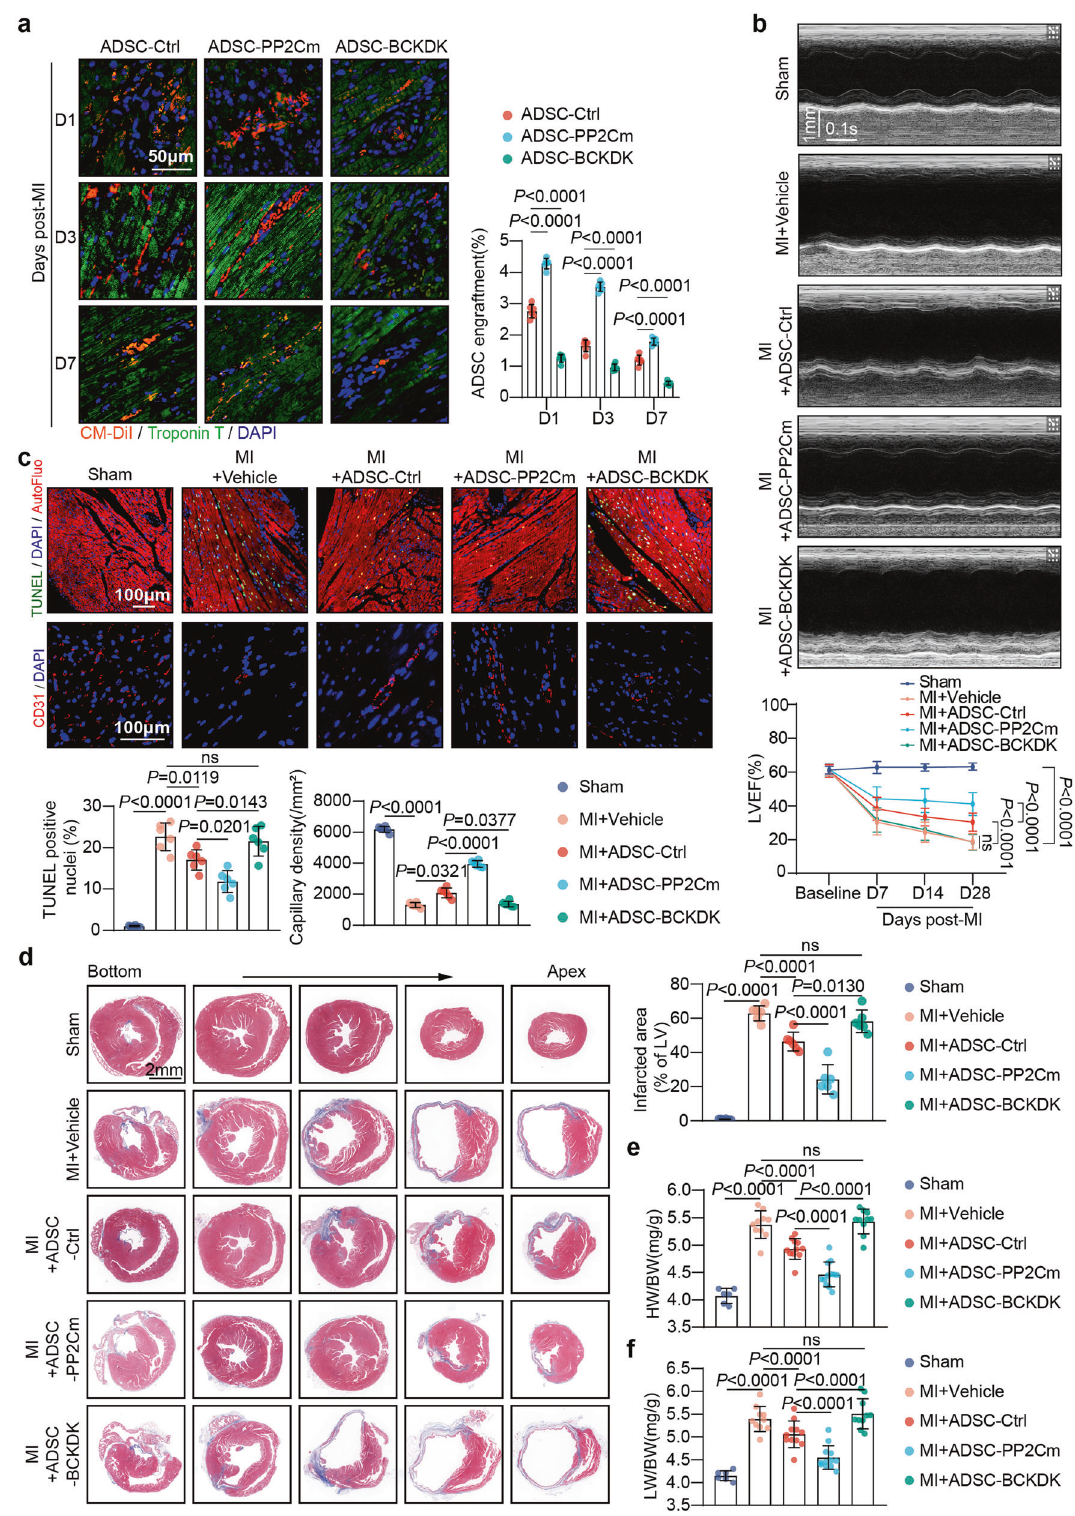
time quantitative PCR (RT-qPCR) was performed using TB Green Premix Ex TaqTM II (TaKaRa, RR820A) with a StepOnePlus real-time PCR system (Applied Biosystems). The primer sequences are presented in supplementary Table 2.